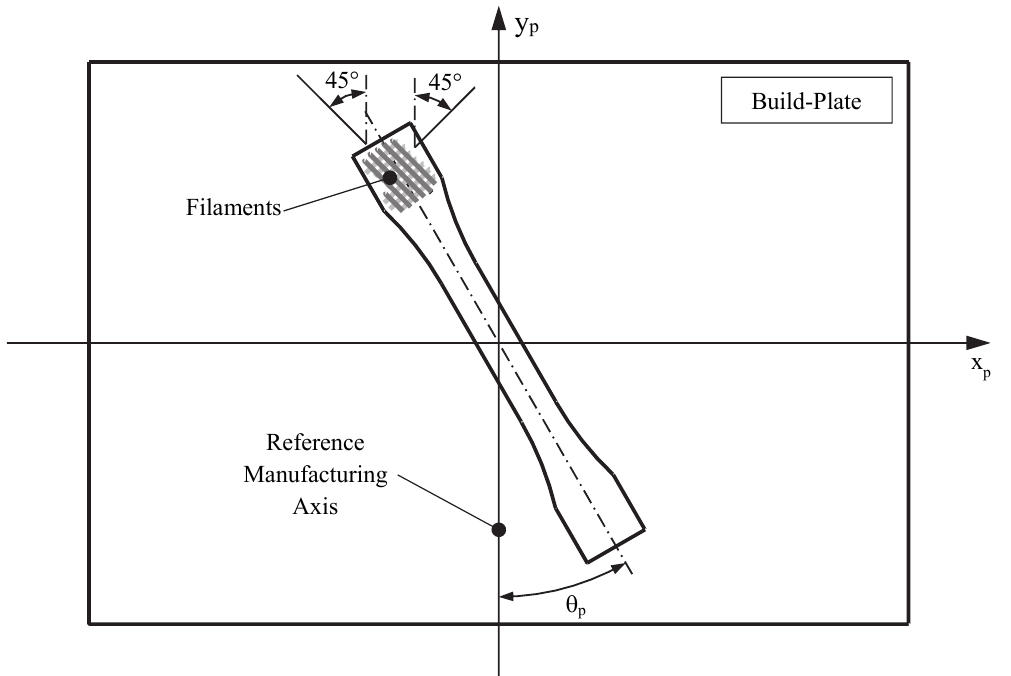
Figure 2: Manufacturing direction and orientation of the deposition